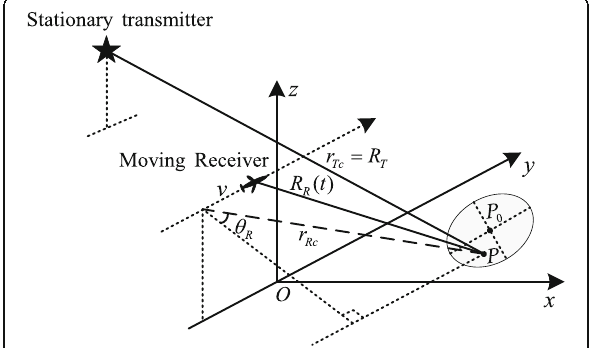
Fig. 1 The imaging geometry model of strip-map BiSAR with stationary